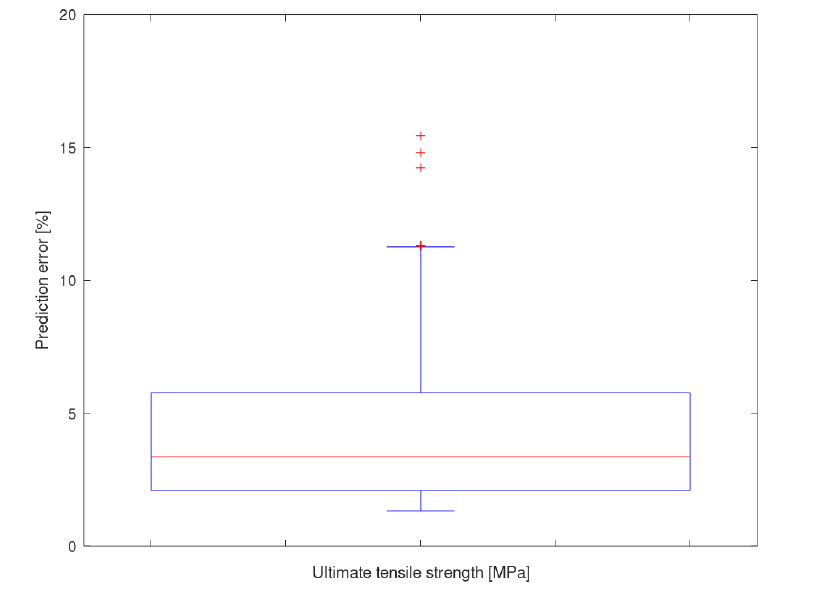
Figure 10. Prediction deviation of the ultimate tensile strength for all iterations.